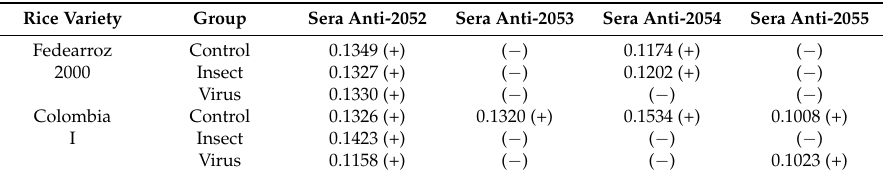
Table 5. Optical densities in specific serological recognition of rice proteins in leaf extracts using sera from mice inoculated with peptide dendrimers from two common proteins 2052 (FHA protein), 2054 (Ferredoxin-NADP(H) oxidoreductase), and two identified only in Colombia I variety 2053 ( α -galactosidase), 2055 (tapetum-specific zinc finger).